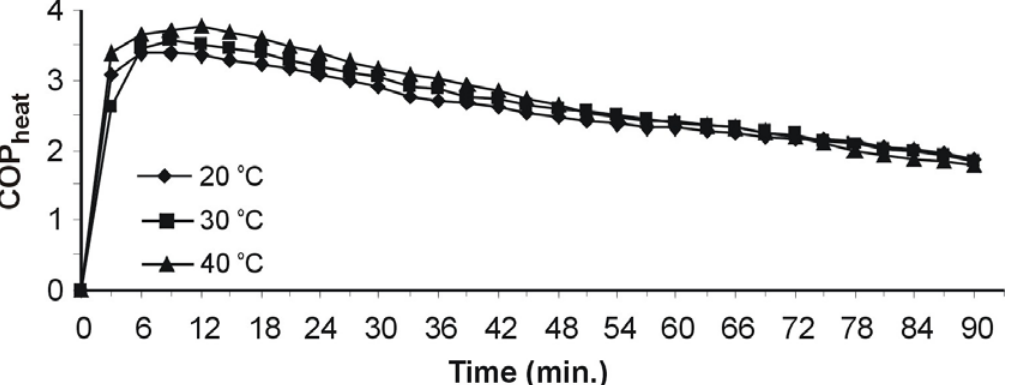
Figure 10. The variation of the heating coefficients of performance at the different waste water temperatures for the circulation pump flow rate CP II during the experiment.